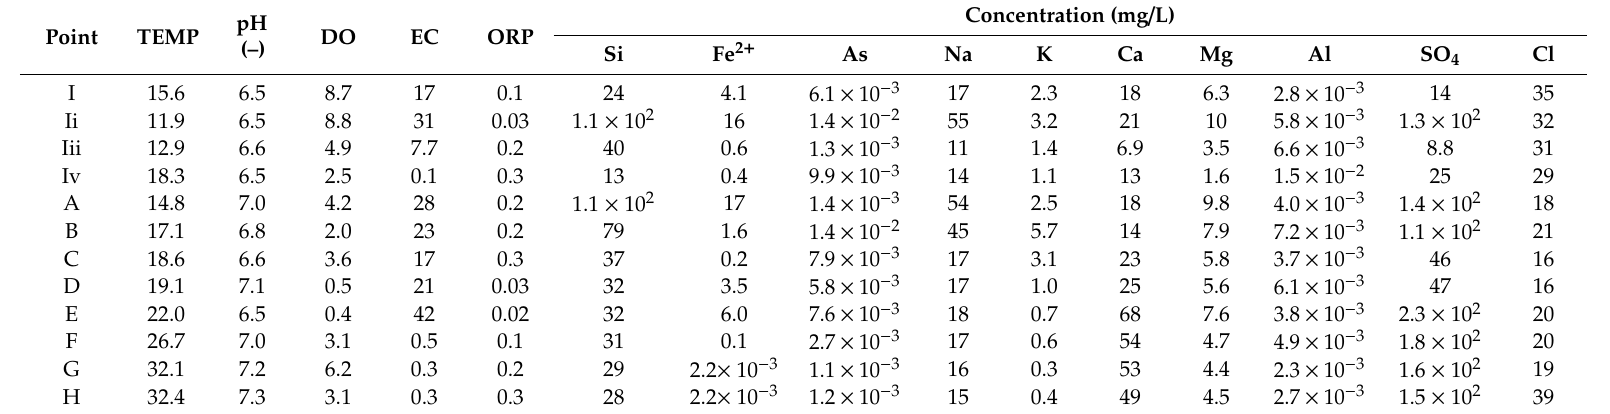
Table 3. Properties of the water sample obtained during field survey in summer 2016.